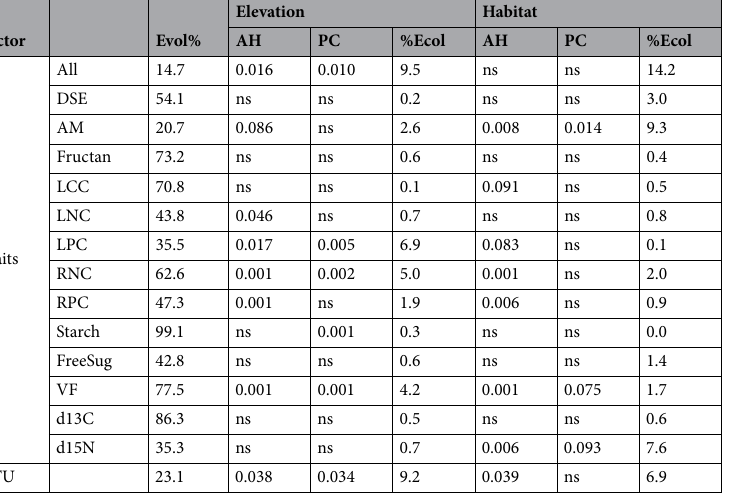
Table 1. Partial tests in RDA of relationships between individual traits and OTU composition (in rows), and ecological parameters (elevation and habitat with elevation as a covariate). AH headed columns refer to ahistorical comparisons (i.e. without phylogenetic corrections), while PC headed columns refer to models with a correction for phylogenetic relatedness. Individual cells in AH and PC columns show Type I error probability estimates (adjusted by Bonferroni correction within test families) or ns when adjusted p ≥ 0.1. The percentage of trait variation explained by phylogenetic relatedness (Evol) between the species, and by the ecological factors (Ecol – either for Elevation or Habitat) in the phylogeny-corrected analyses, are shown. AMF – intensity of AMF colonization, DSE – intensity of DSE colonization, LCC - leaf carbon contents, LNC - leaf nitrogen contents, LPC - leaf phosphorus contents, RPC - root phosphorus contents, RNC - root nitrogen contents, d13C - leaf δ 13 C content, d15N - leaf δ 15 N content.